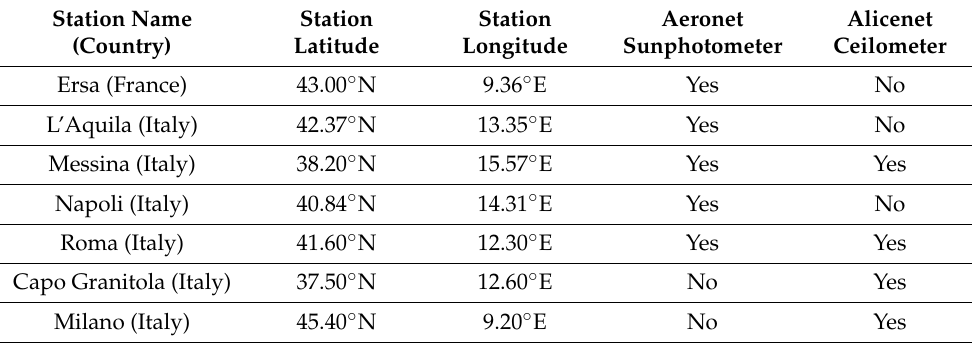
Table 6. Location of the AERONET and ALICENET stations selected for this